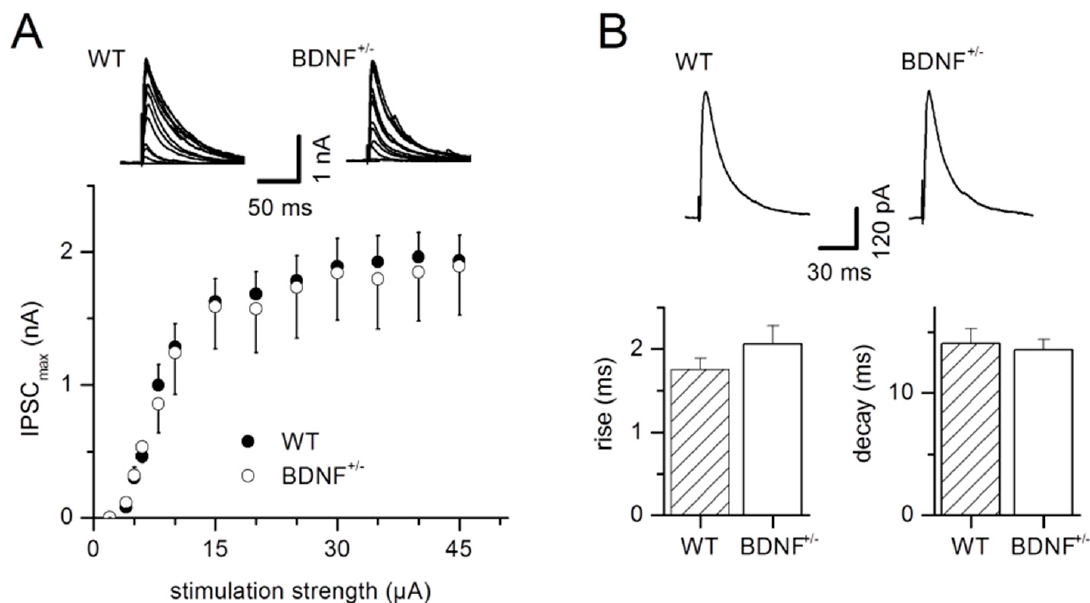
Figure 1. Basal synaptic e ffi cacy and inhibitory postsynaptic current (IPSC) kinetics are unchanged in brain-derived neurotrophic factor heterozygous knockout (BDNF +/ − ) mice. ( A ) Input–output relationship, measuring IPSC amplitudes as a function of stimulus intensity, displayed no change between the two experimental groups. Traces depict IPSC amplitudes with rising stimulation strength for a representative wild-type (WT) or BDNF +/ − neuron, respectively. WT: n = 9 neurons from 9 animals, BDNF +/ − : n = 8 neurons from 6 animals. ( B ) Neither rise time nor decay time constants ( τ ) of evoked IPSCs di ff ered between genotypes. Typical evoked IPSCs of a WT and BDNF +/ − lateral amygdala (LA) projection neuron, respectively, are shown at the top. WT: n = 9 neurons from 5 animals, BDNF +/ − : n = 9 neurons from 6